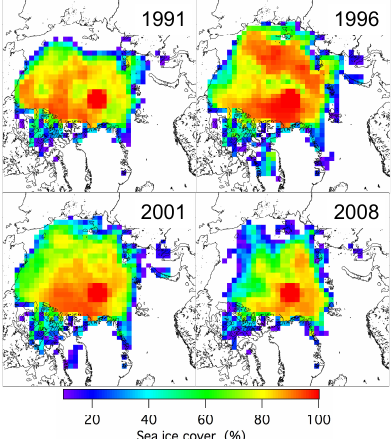
Figure 3. Gridded average Arctic sea ice cover in percent during the four Oden cruises in 1991, 1996, 2001, and 2008. Only cells with at least 100 ice pixels per cell are plotted. The blind spot of satellite data north of 86 ◦ N is assumed to have 100% ice